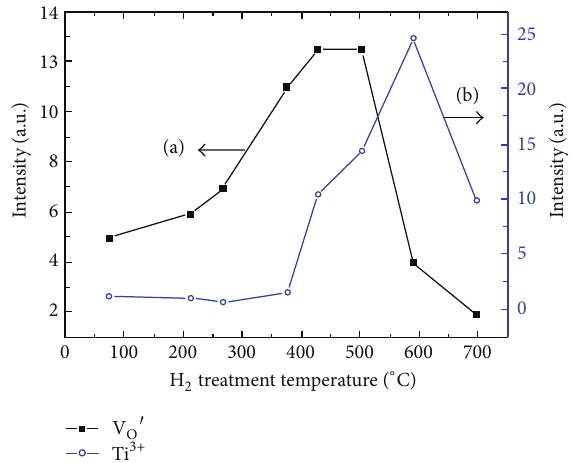
Figure 4: EPR intensity of oxygen vacancies and Ti 3+ generation under thermal treatment with H 2